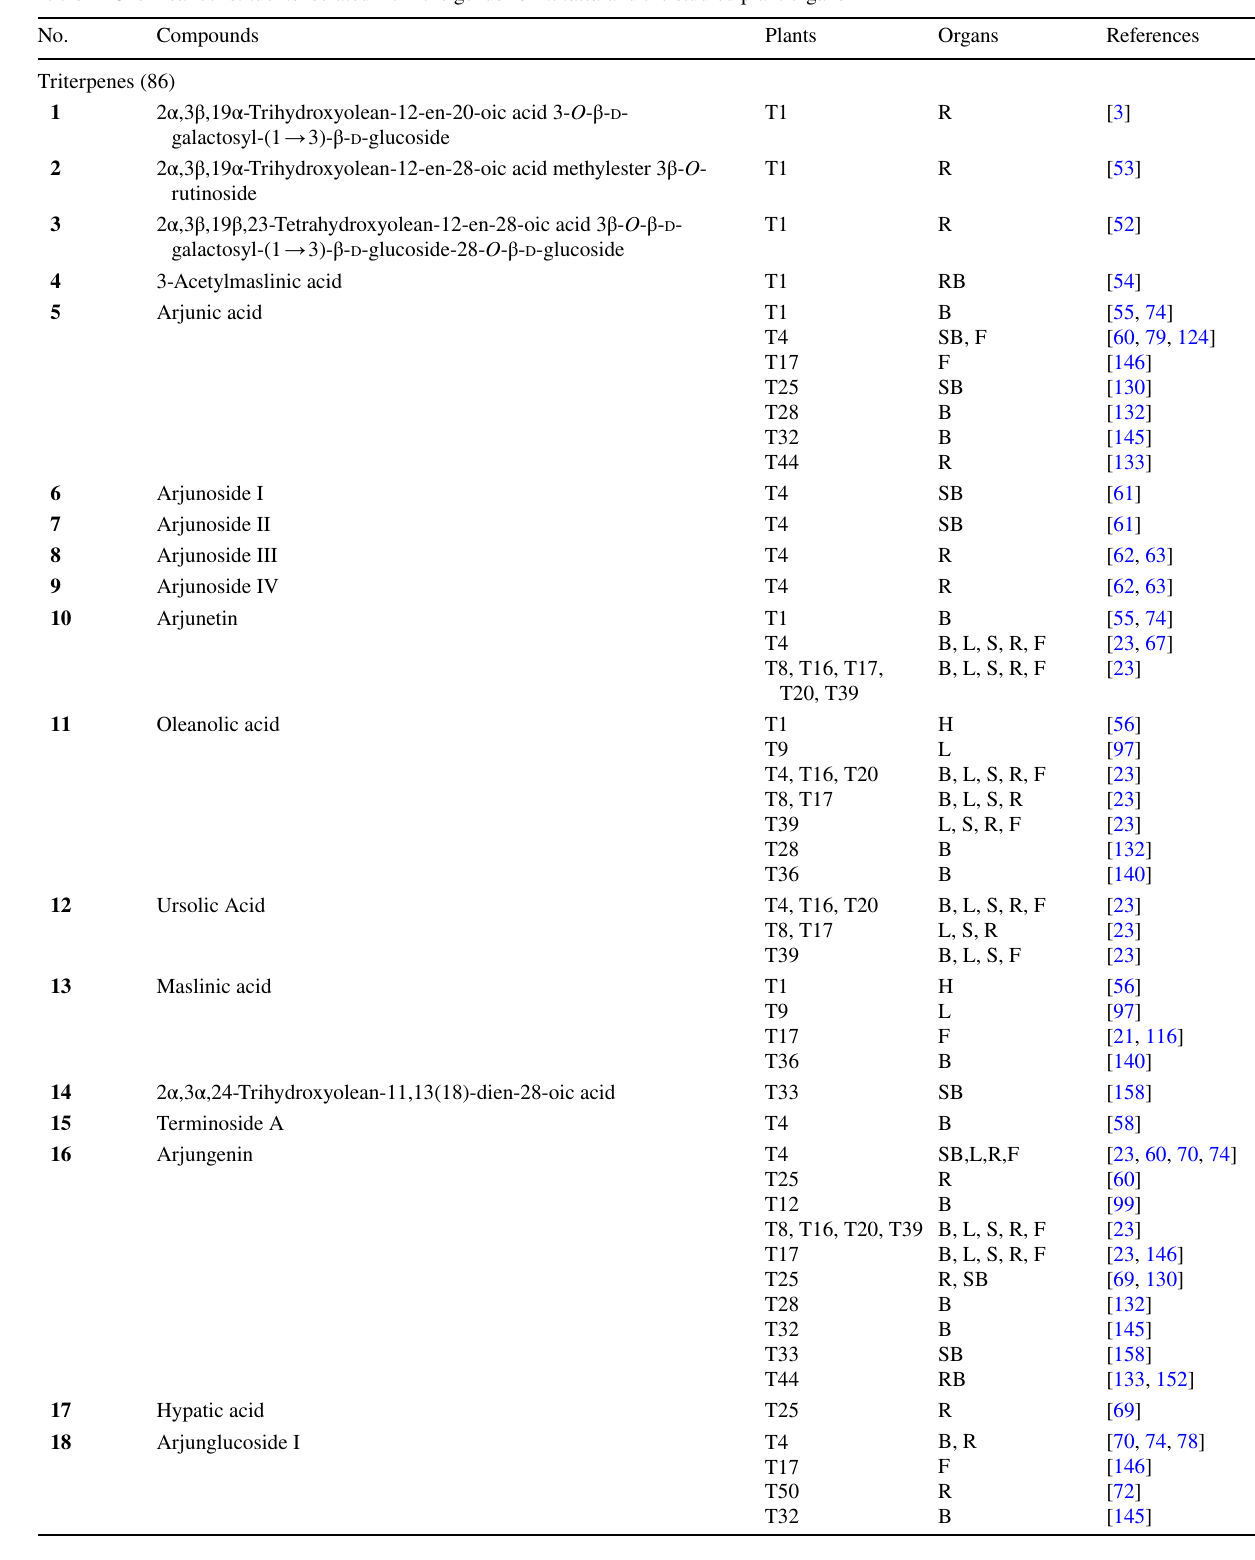
Table 2 Chemical constituents isolated from the genus Terminalia and the studied plant organs No. Compounds Plants